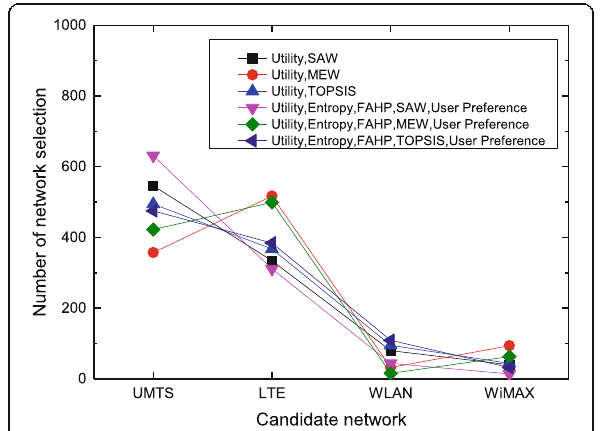
Fig. 13 Number of network selection of candidate networks for different algorithms for voice application